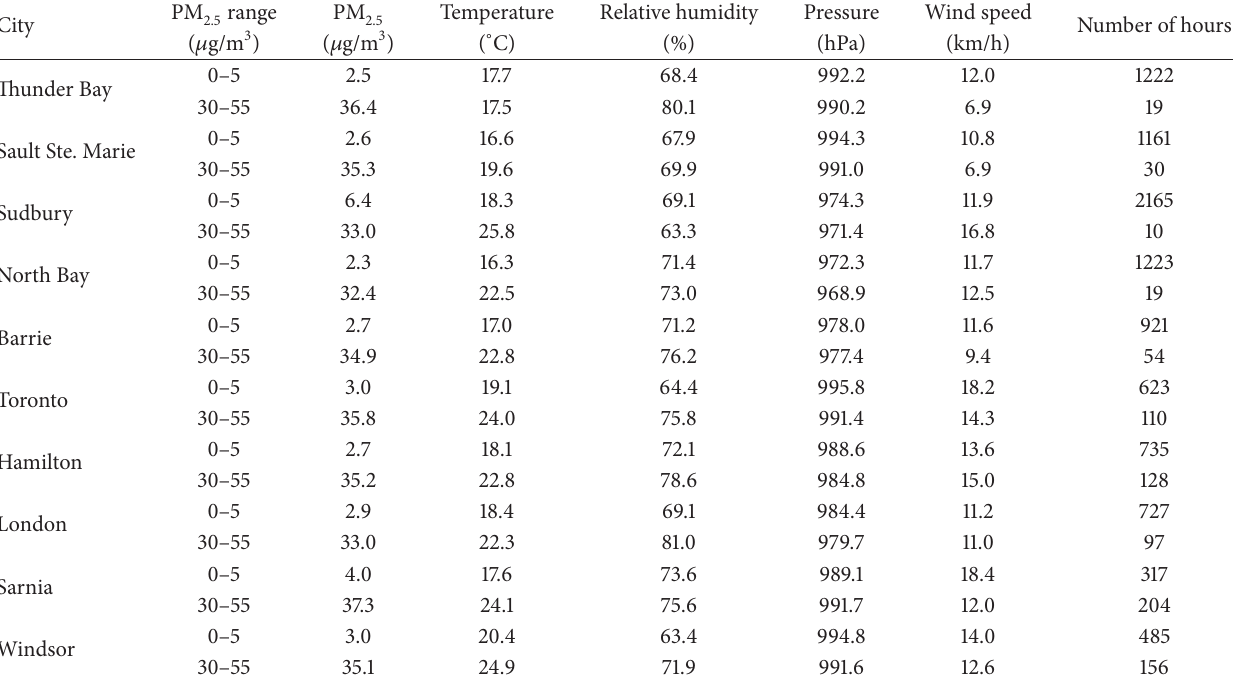
Table 3: Comparison of mean hourly meteorological conditions at the surface (temperature, humidity, surface pressure, and wind speeds) ≤ 5 𝜇 g/m 3 ) and polluted (PM ≥ 30 𝜇 g/m 3 ) times at cities in southern Ontario. The cities are ordered by descending for both clear (PM 2.5 2.5 latitude (see Table 1 and Figure 1(a)).